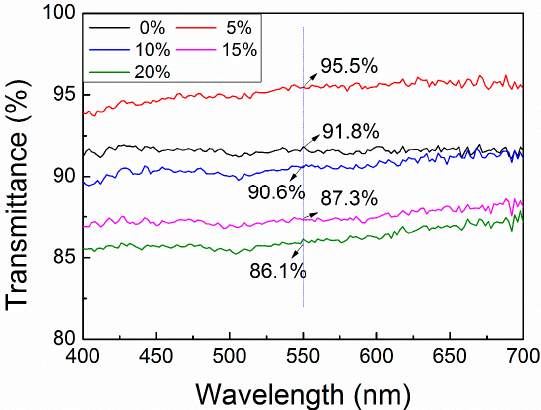
Figure 5. Transmittance of sc -PLA/PMMA nanofiber filter with different sc -PLA